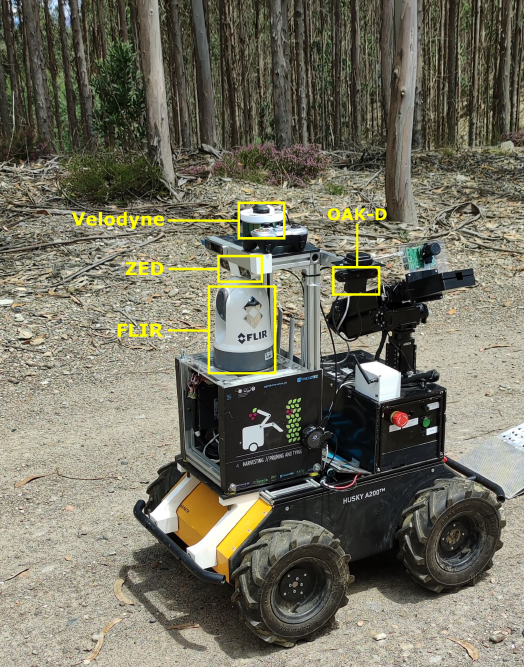
Figure 3. Lateral view of the ground mobile robotic platform AgRob V16 with the sensors annotated. The dataset is available in the Robot Operating System (ROS) format, it is made up by nine rosbags , and it includes visible, thermal, and depth images, and even point clouds. The dataset was recorded during the navigation of the robot (manually controlled